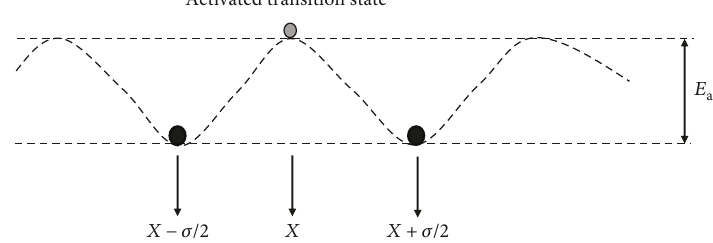
Figure 3: Hopping model for surface di ff